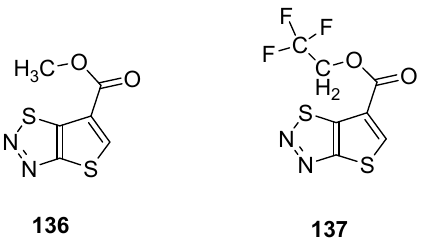
and displayed excellent inhibition activities against diseases such as M. melonis, (90% for 136 and 69% for 137 ), C. cassiicola (77% for 136 and 52% for 137 ), P. syringae pv. Lachrymans (42% for 136 and 42% for 137 ) and P. infestans (81% for 136 and 67% for 137 ) when results were compared with commercial BTH plant activator. The structural motifs 136 and 137 displayed significantly better therapeutic efficacy than BHT commercial drug, but the scaffold 136 had better plant activating potency than scaffold 137 [88].